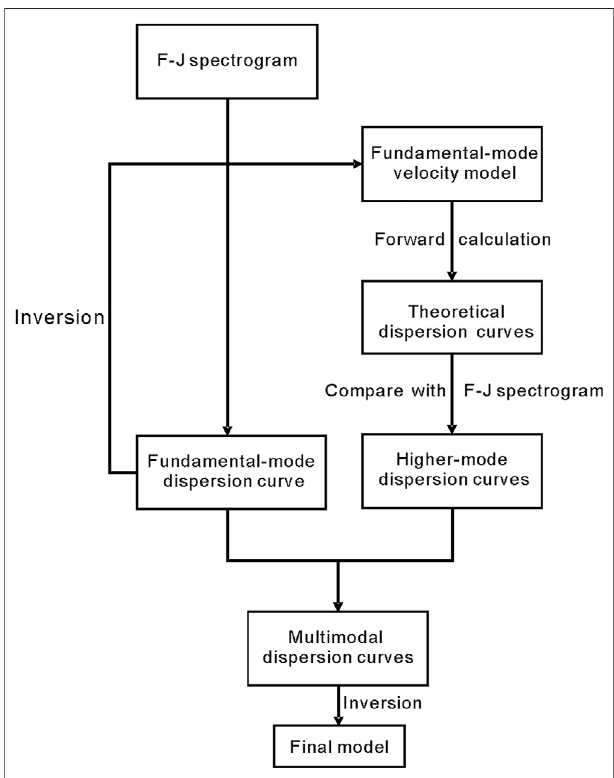
FIGURE 2 | Multimodal dispersion curve identi fi cation work fl